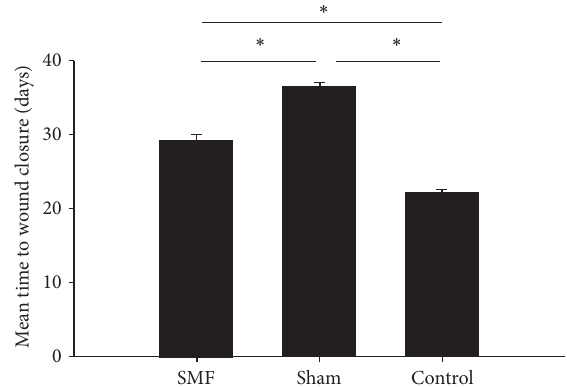
Figure 3: Comparison of mean time to wound closure in three groups, ∗ 𝑃 < 0.05 , statistically significant compared to other